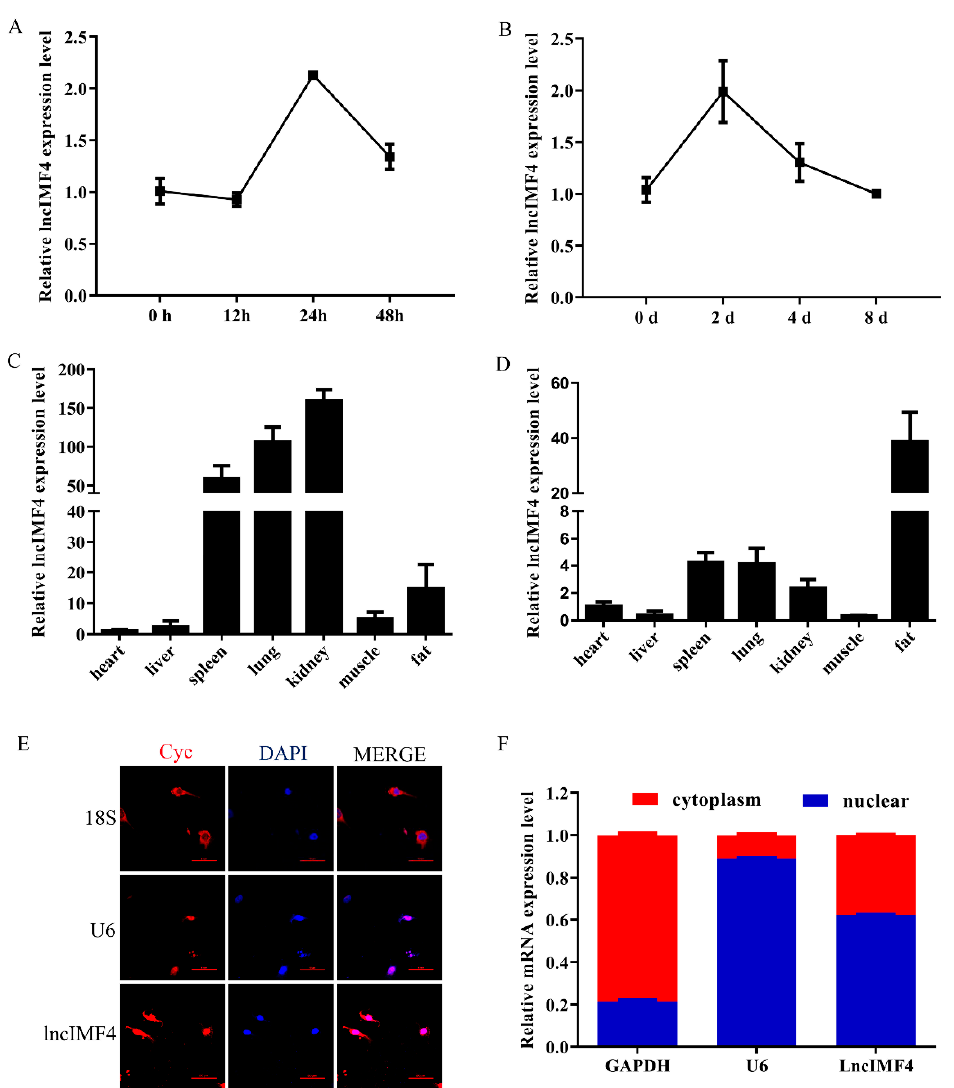
Figure 2. The expression pattern of lncIMF4 in pig and its subcellular location in adipocyte. ( A ) The levels of lncIMF4 during porcine intramuscular adipocytes proliferation. ( B ) The levels of lncIMF4 during adipocytes differentiation. ( C , D ) The levels of lncIMF4 in heart, liver, spleen, lung, kidney, muscle, and fat from 3-day-old piglets ( C ) and 180-day-old pig ( D ). ( E ) Subcellular localization of lncIMF4. ( F ) LncIMF4 expression in cytoplasm and nucleus. The results were representative of means ± SEM of three independent experiments.